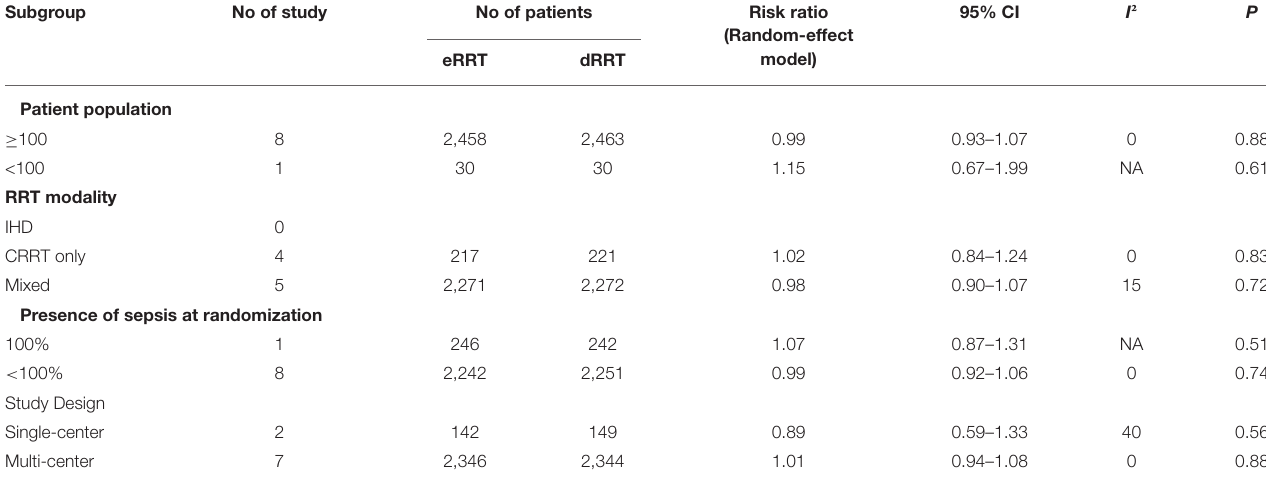
TABLE 6 | Subgroup analysis for all-cause mortality at day